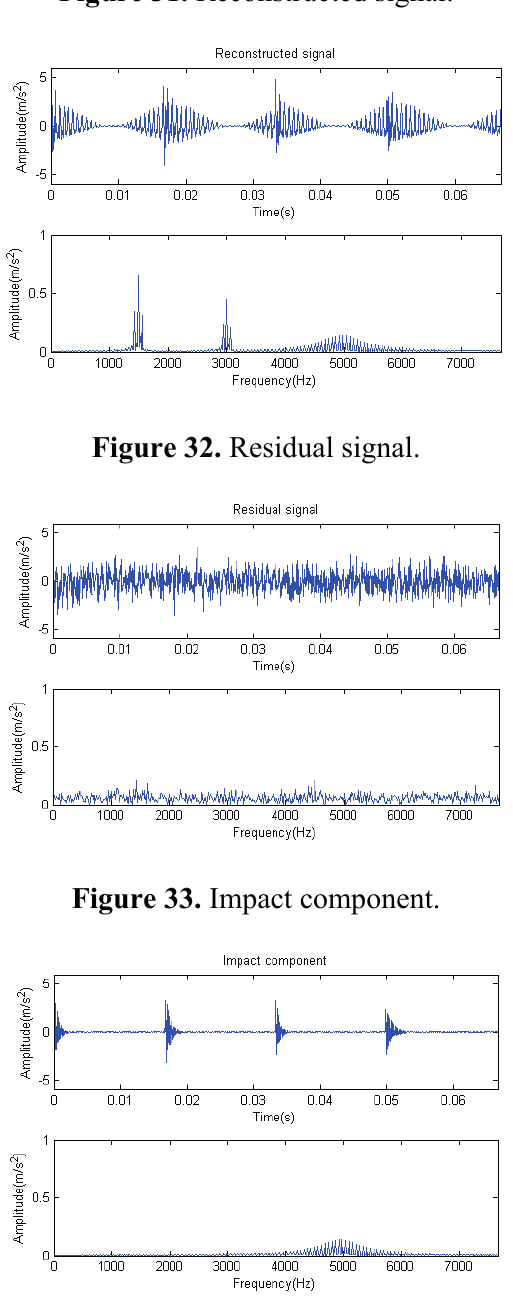
Figure 31. Reconstructed signal.